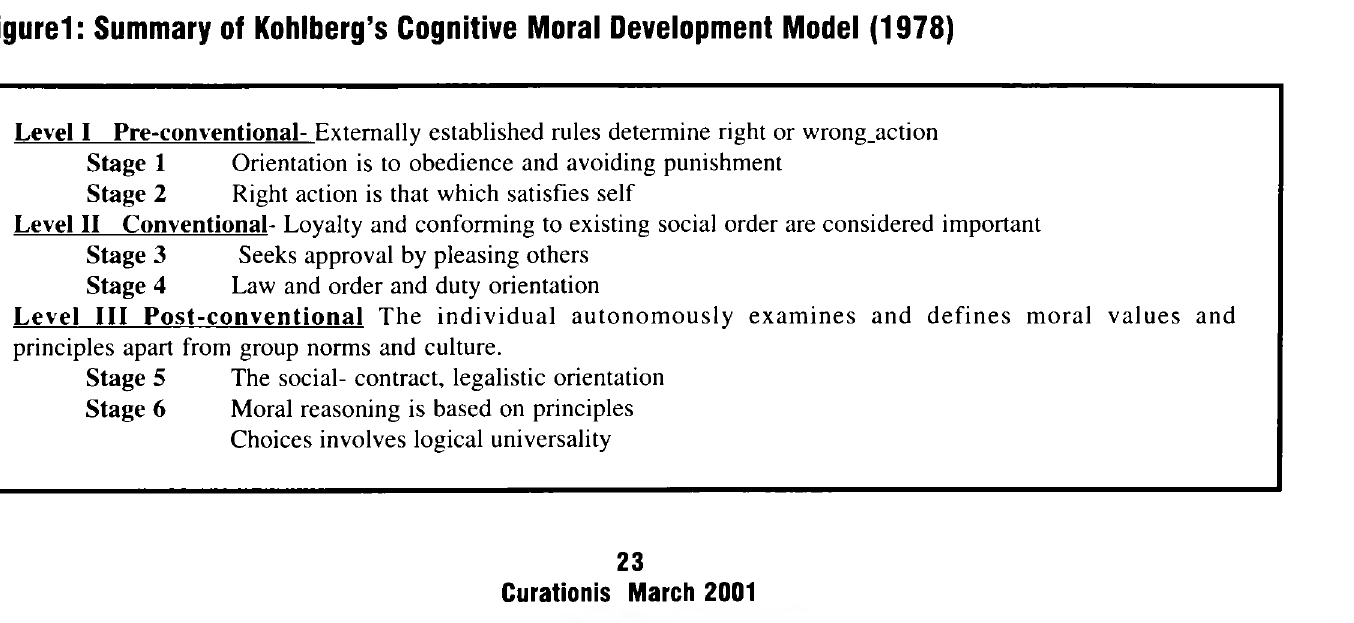
Figurel: Summary of Kohlberg’s Cognitive Moral Development Model (1978)